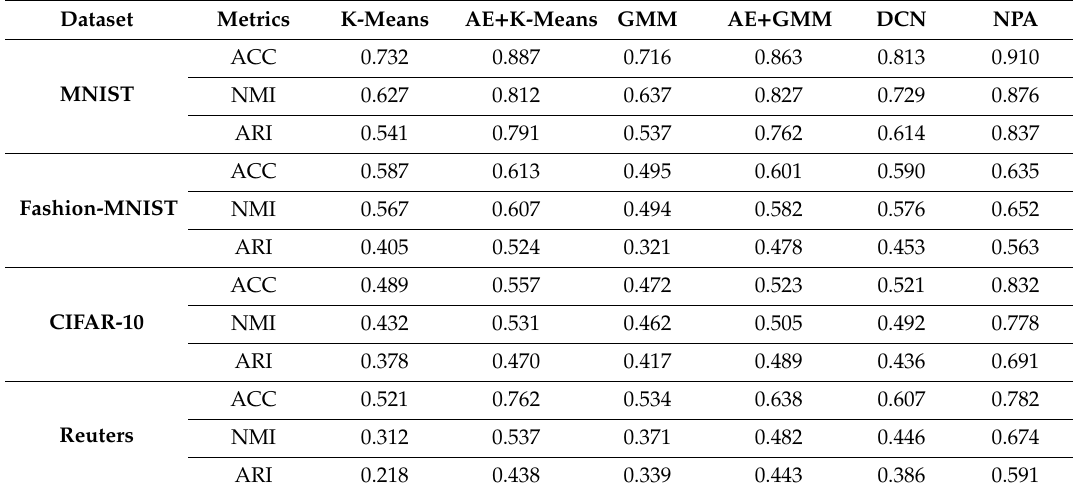
Table 2. Clustering performance of di ff erent algorithms on public datasets on clustering accuracy (ACC), normalized mutual information (NMI) and adjusted Rand index